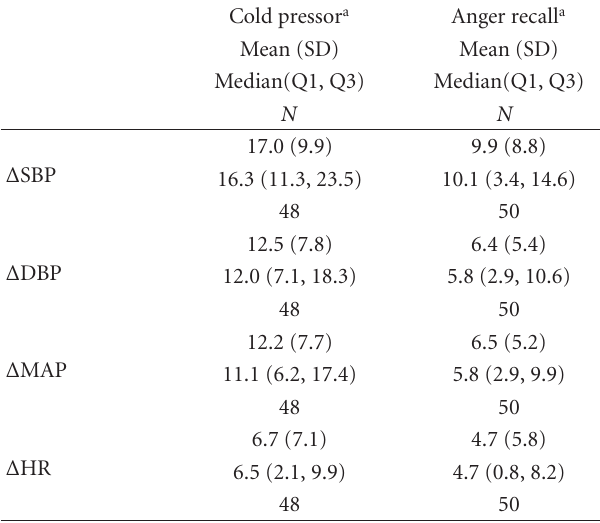
anger recall. Cold pressor